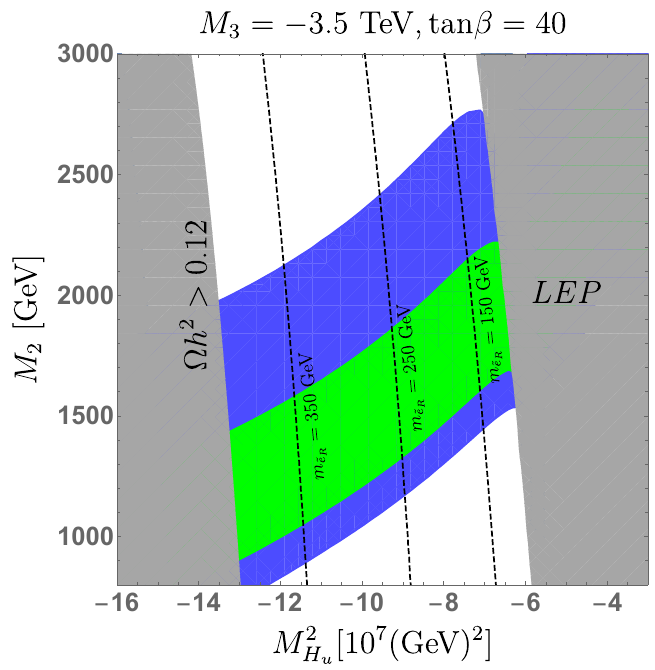
Figure 5 . Region of parameter space where the dark matter abundance is obtained via ~ B (cid:0) ~ l co-annihilation. The green (blue) regions are consistent with the muon g (cid:0) 2 at 1(2) (cid:27) . In the left grey region the sleptons become too heavy to achieve the correct relic abundance; the right grey region is excluded by slepton searches at LEP